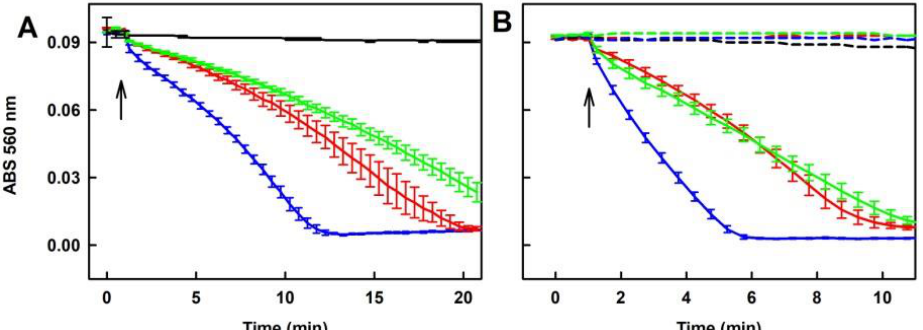
Figure 9. Time-dependent reduction of the • cPTIO radical by the studied compounds. Reduction